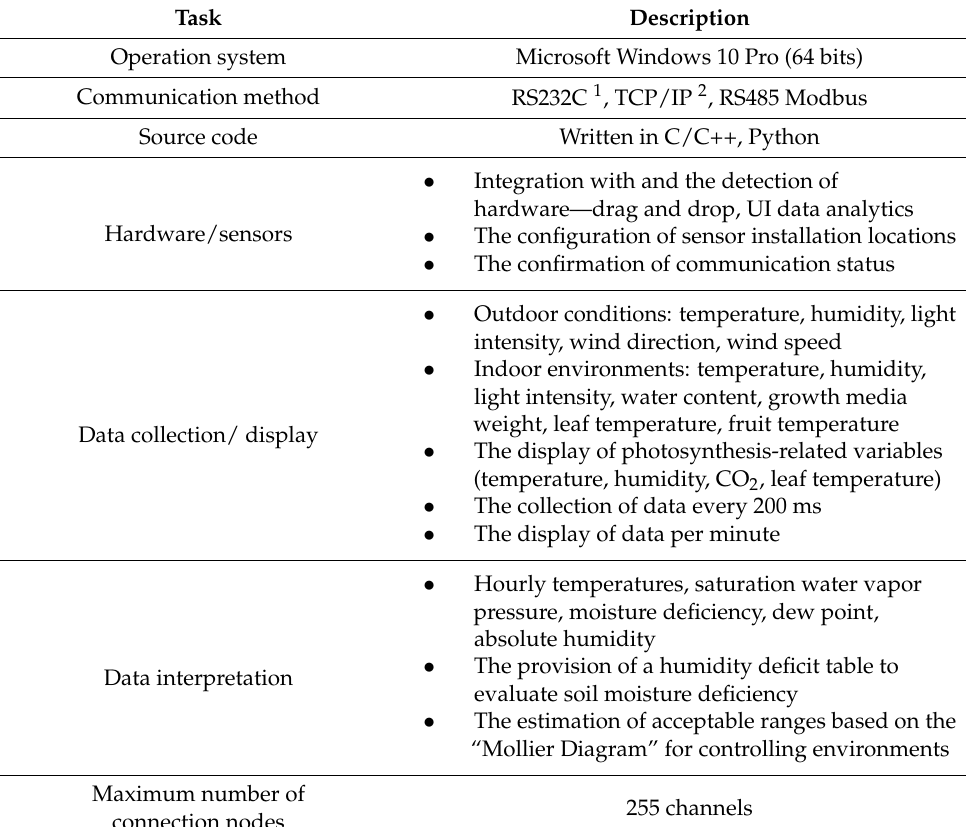
Table 2. Specifications for hardware and software developed for this